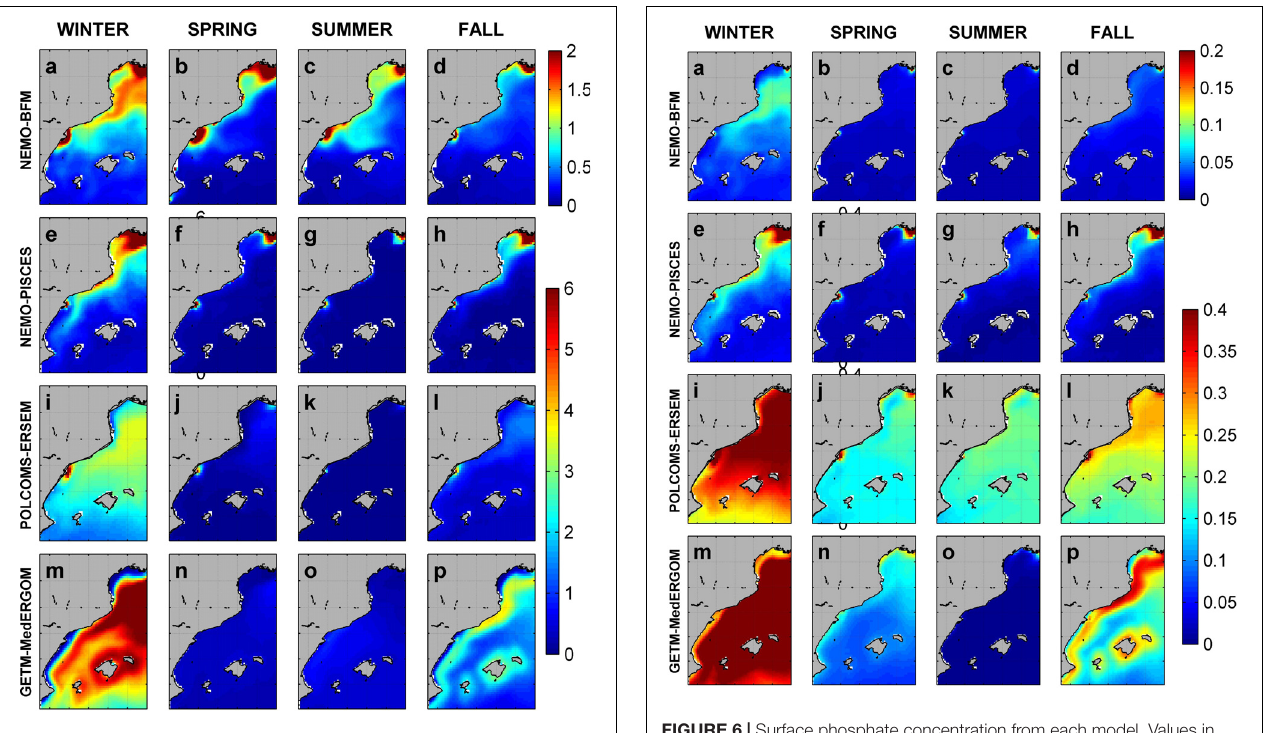
FIGURE 5 | Surface nitrate concentration from each model. Values in µ M. Nitrate levels around Rhone River reach 10 µ M, but in order to show the spatial variability in the rest of the area, the color bar saturates at 6 µ M. NEMO-BFM (a–d) , NEMO-PISCES (e–h) , POLCOMS-ERSEM (i–l) , and GETM-MedERGOM (m–p) .